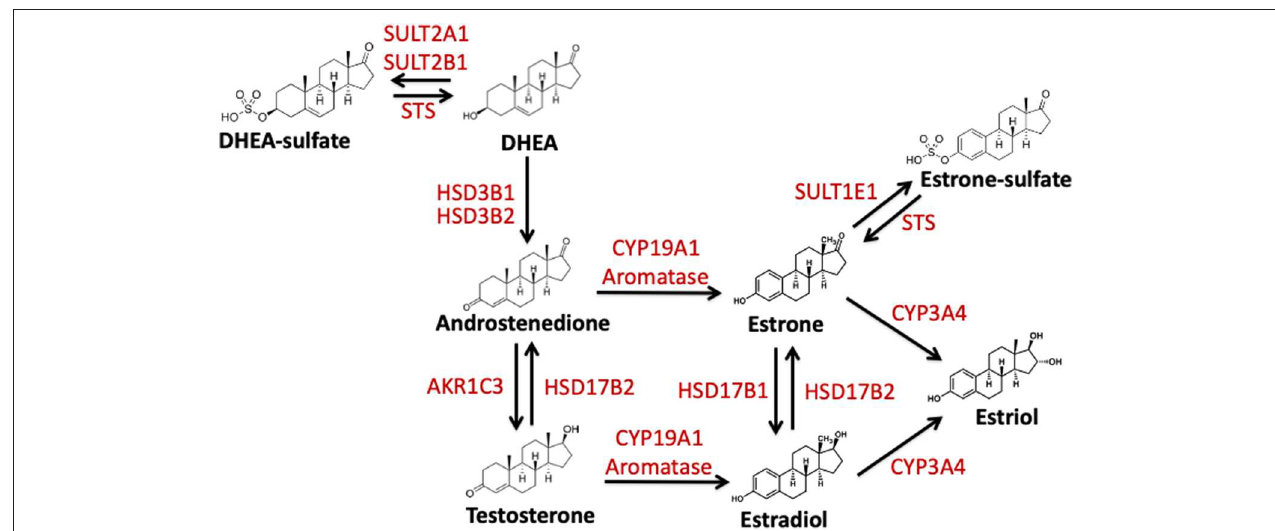
FIGURE 1 | Schematic representation of the enzymatic conversion and synthesis of biologically active estrogens. Estrogens are produced from C19 steroid precursors through several enzymatic conversions. DHEA, dehydroepiandrosterone. DHEA-S, dehydroepiandrosterone-sulfate; Aromatase/CYP19A1, estrogen synthase; HSD3B1, hydroxysteroid 3 beta-1; HSD3B2, hydroxysteroid 3 beta-2; HSD17B1, hydroxysteroid 17-beta dehydrogenase; HSD17B2, hydroxysteroid 17-beta dehydrogenase 2; STS, steroid sulfatase; SULT2A1, Sulfotransferase Family 2A Member 1; SULT2B1, Sulfotransferase Family 2B Member 1;